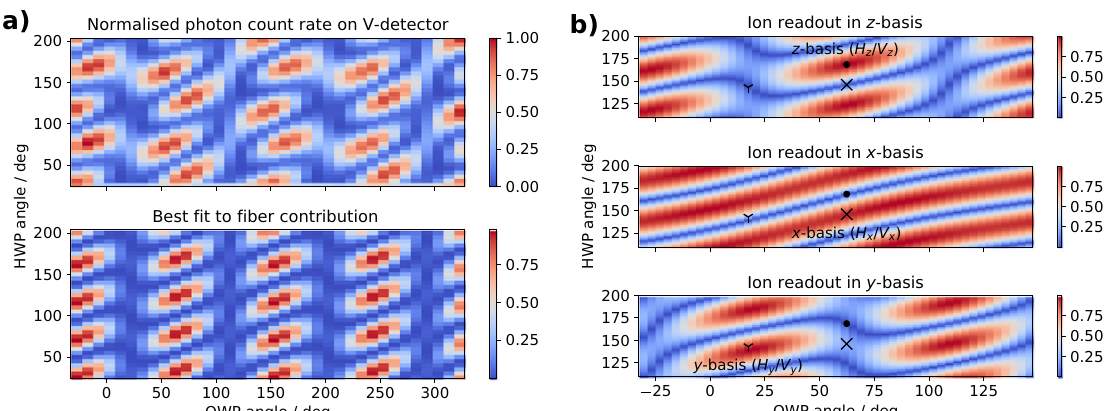
Fig. 4 Selection of the photon readout basis. a Characterisation of the photon detection setup using a reference laser as shown in Fig. 1. The normalized count rate of re fl ected photons on the V-detector for different waveplate angles is shown (top). Fit of the data assuming the fi ber to be an arbitrary polarization element (bottom). b Calculated correlation heat-map for different atomic qubit basis using fi ber parameters determined from the fi t in a ). The optimal waveplate settings of the photon readout basis σ i used for the measurements in Fig. 2 are labeled accordingly with lower indices H i /V i ; i ∈ ( x , y , z